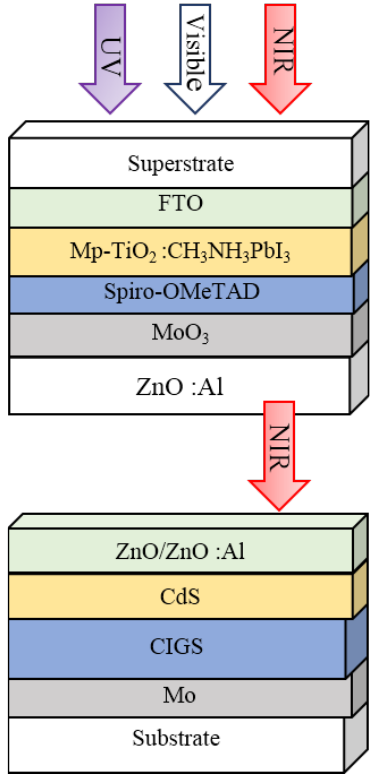
Figure 12: Four terminal perovskite / CIGS tandem cell structure